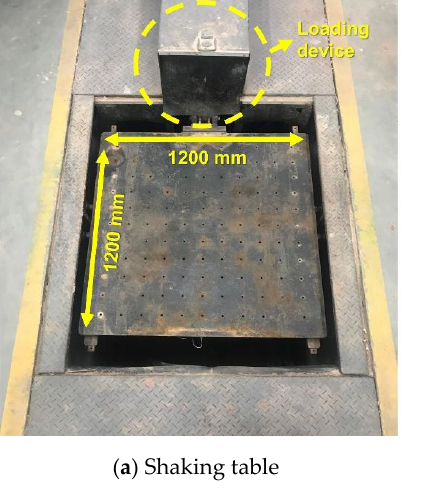
Figure 1. Shaking table facility.